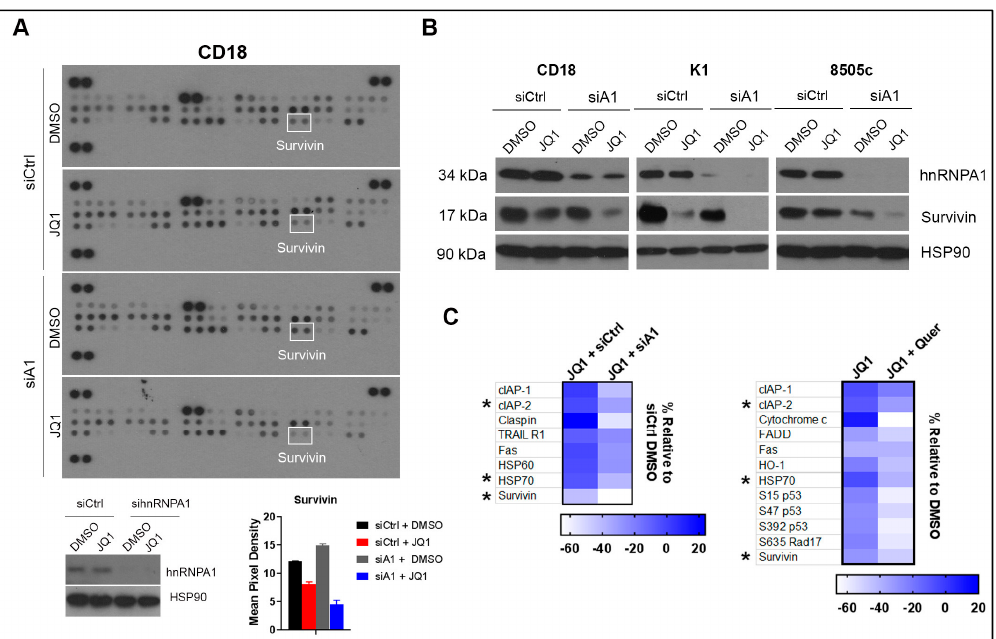
Figure 5. Combination of hnRNPA1 knockdown and JQ1 decreases Survivin. ( A ) CD18